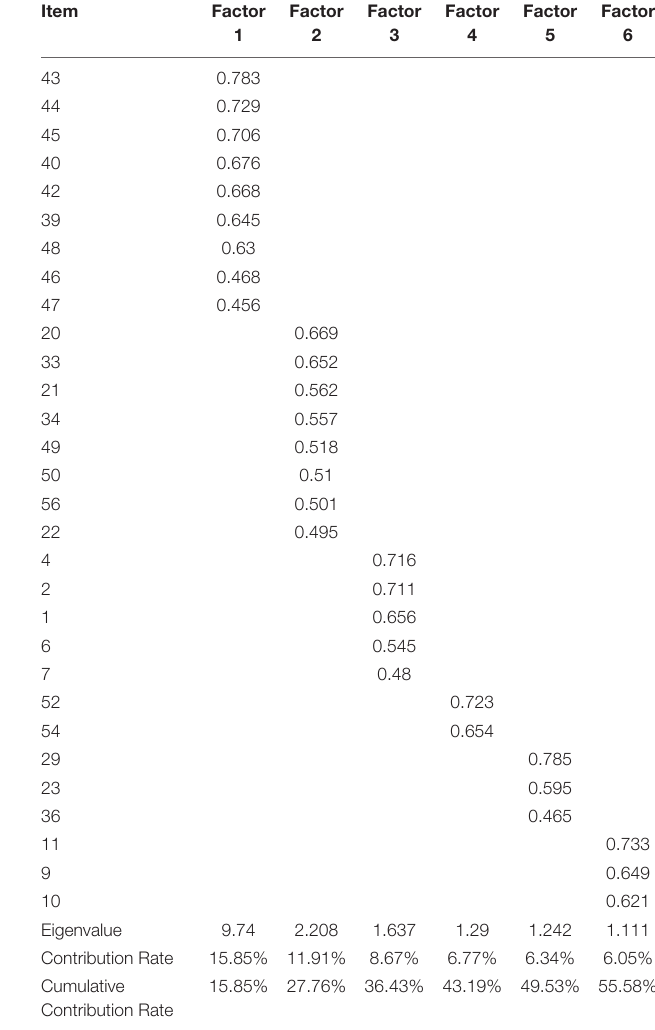
TABLE 6 | Results of component matrix after rotation in Study 2 ( n =